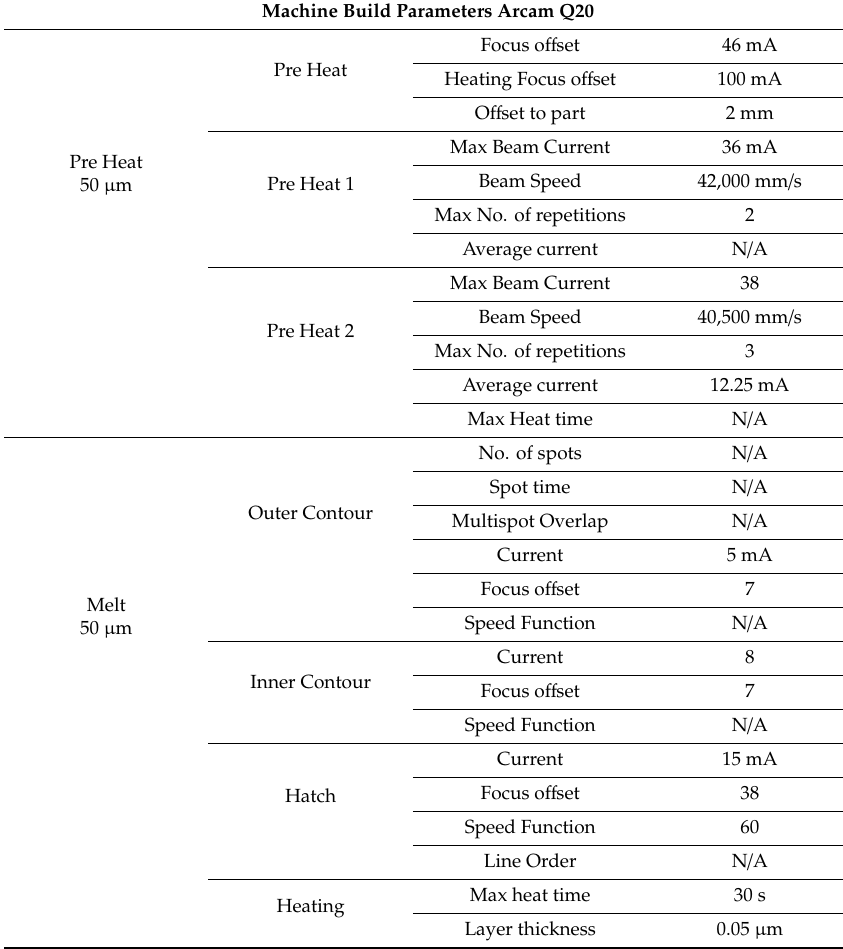
Table 2. Build Parameters for Arcam Q20